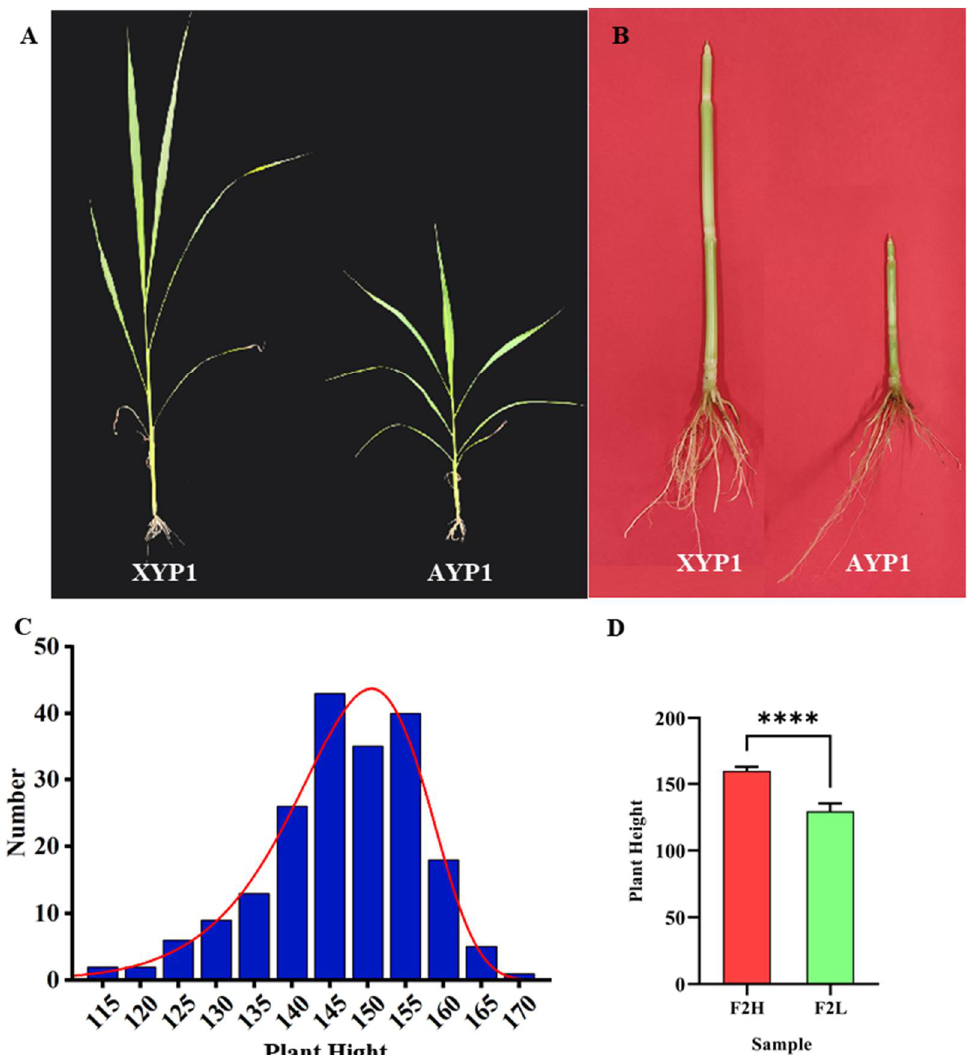
Figure 1. Field phenotype of foxtail millet’s plant height ( A , B ), plant height frequency distribution map of F 2 population in the field ( C ), and the performance of plant height in two extreme mixed pools of plant heights ( D ). Asterisks indicate significant differences at various thresholds (**** p < 0.0001). Error bars represent the mean SE of 30 plants of foxtail millet in the mixed pool.